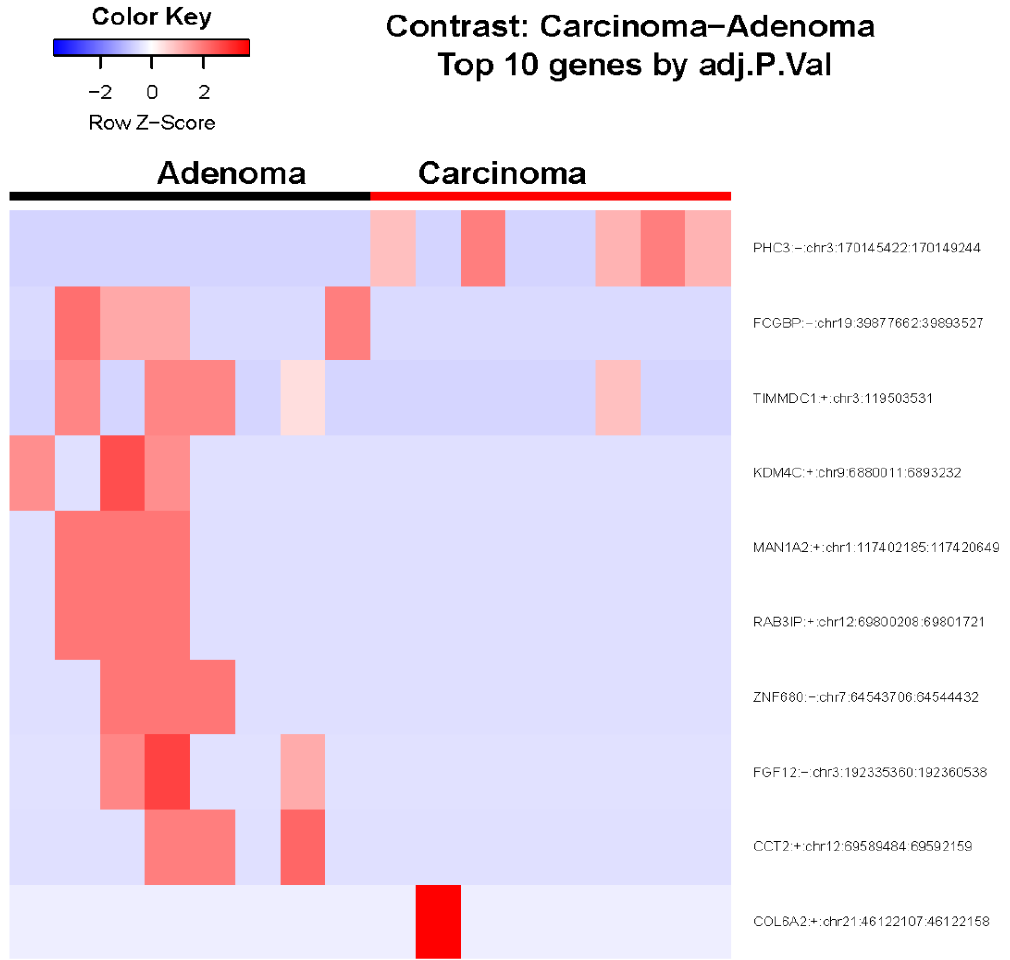
Figure 2. Heatmap showing the variation of circRNA expression levels between ACC vs. ACA samples. Adj.P.Val: adjusted p ‐ value.